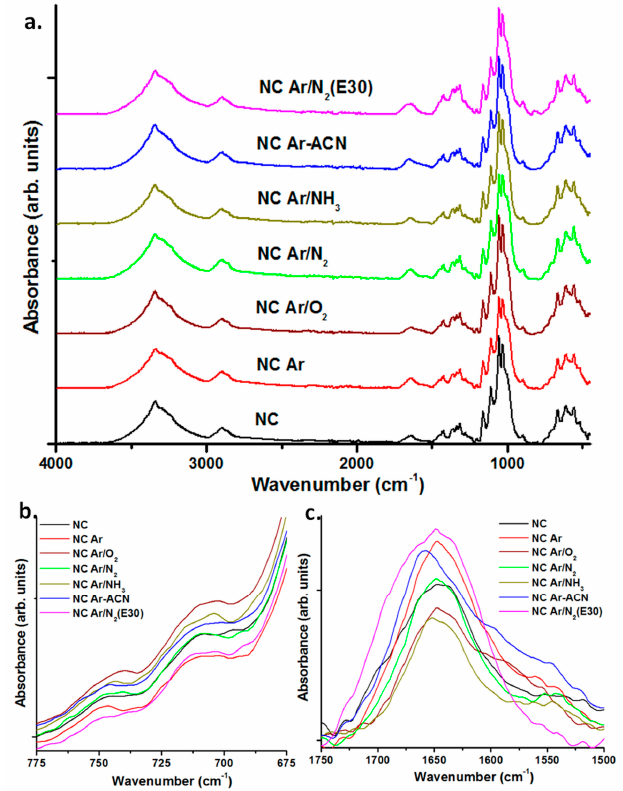
Figure 7. Fourier transform infrared spectroscopy (FTIR) spectra of untreated and plasma treated NC ( a ); zoomed-in regions (775–675 cm − 1 ) ( b ) and (1750–1500 cm − 1 ) ( c ) of the same spectra.